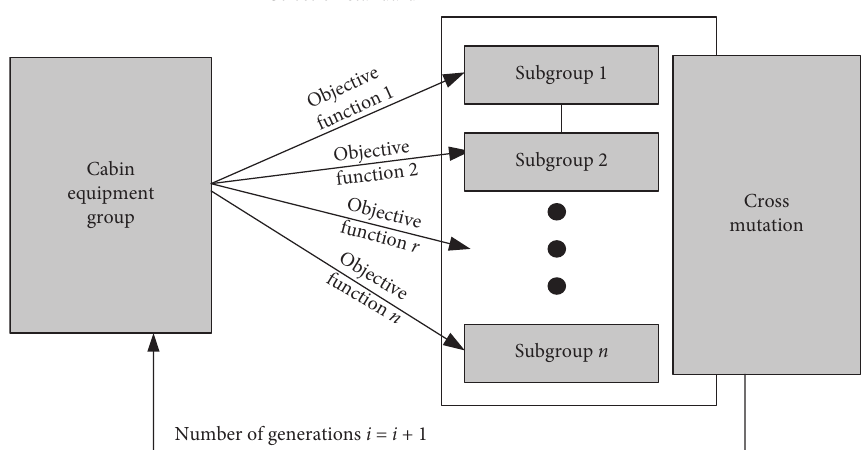
Figure 8: Diagram of parallel selection genetic algorithm after deconstruction and